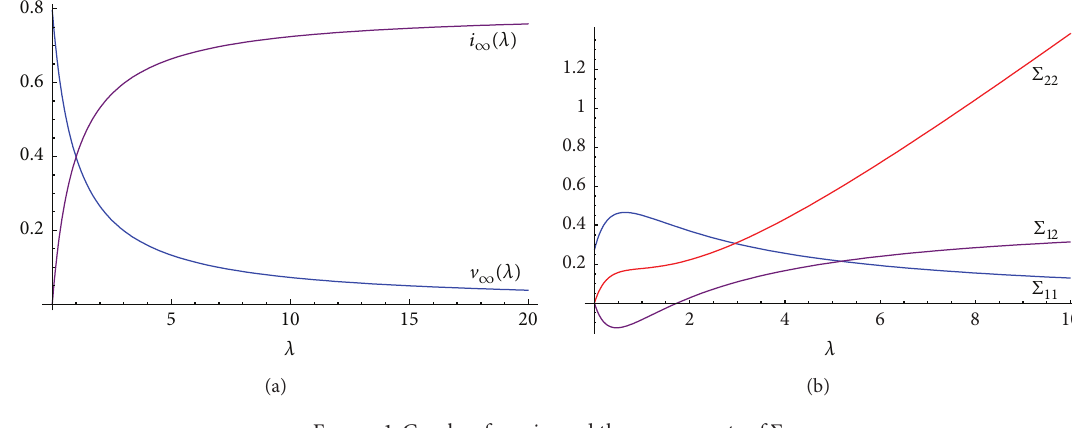
Figure 1: Graphs of V ∞ , 𝑖 ∞ and the components of Σ . Table 1: Values of 𝜆 such that the final proportion of infected individuals does not exceed V max with approximate probability 𝛼 . 𝑛 = 1000 𝑛 = 𝛼